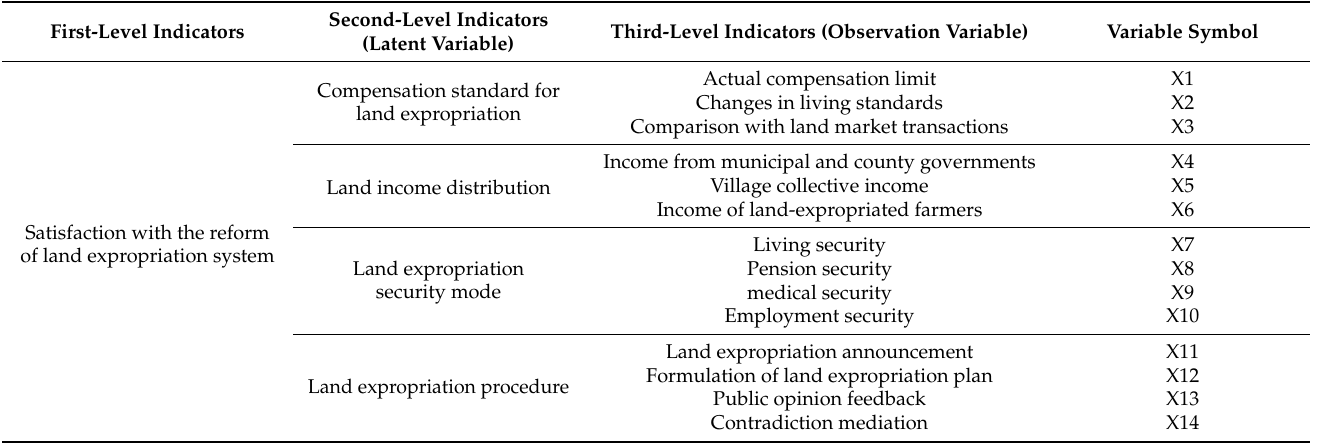
Table 5. Land expropriation system reform and farmers’ satisfaction index